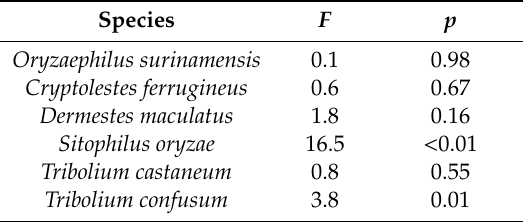
Table 1. Analysis of variance (ANOVA) parameters for different treatments of acclimated and non-acclimated adults * of six stored-product insect species (in all cases, df = 4.40, treatments were: control, non-acclimated, only pre-acclimated, only post-acclimated and both pre and post-acclimated adults) *. Species F p Oryzaephilus surinamensis 0.1 0.98 0.6